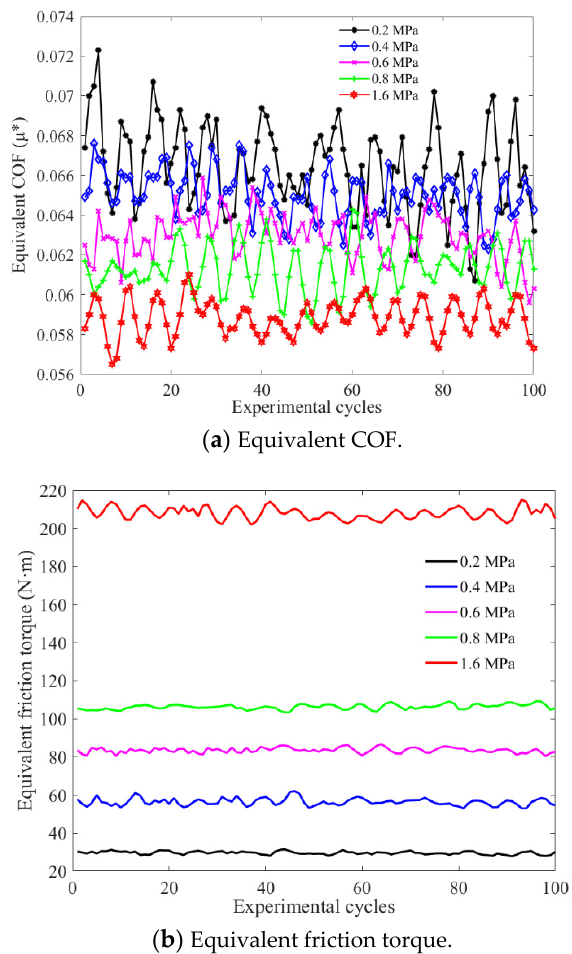
Figure 12. Six-friction pair system. Table 2. Mean values of the two